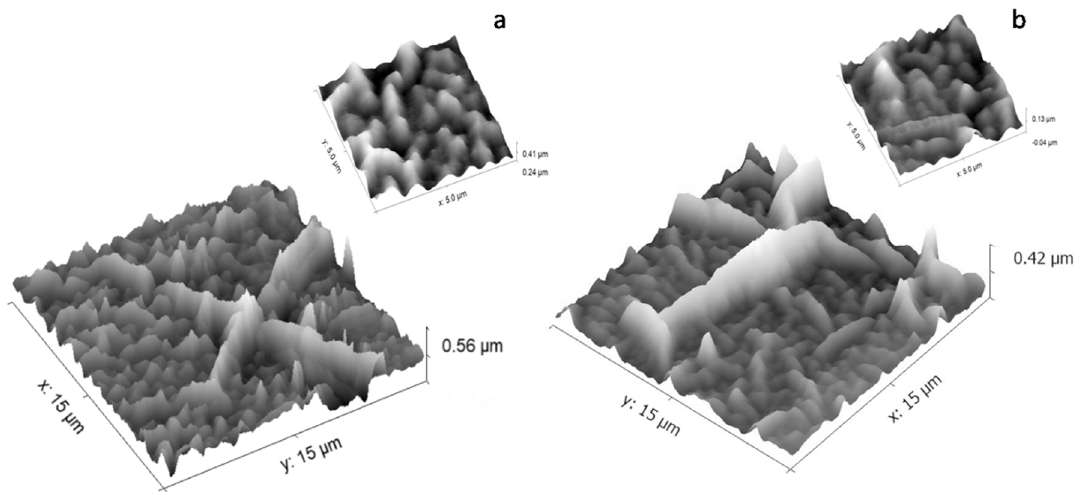
Figure 12. The calcium phosphate layers deposited on polypropylene at: ( a ) p = 1.2 × 10 − 2 mbarr; and ( b ) p = 4.6 × 10 − 3 mbarr; Ar gas working ( b ) p = 4.6 × 10 − 3 mbarr; Ar gas working pressure.